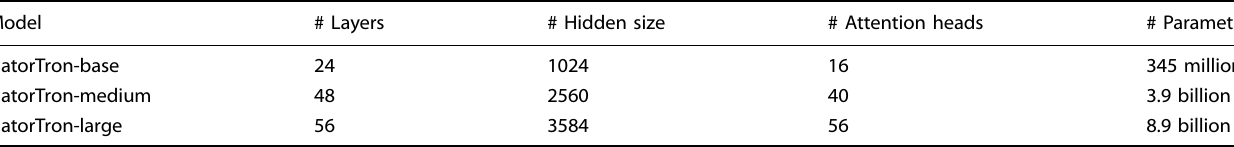
Table 3. Technical details of GatorTron